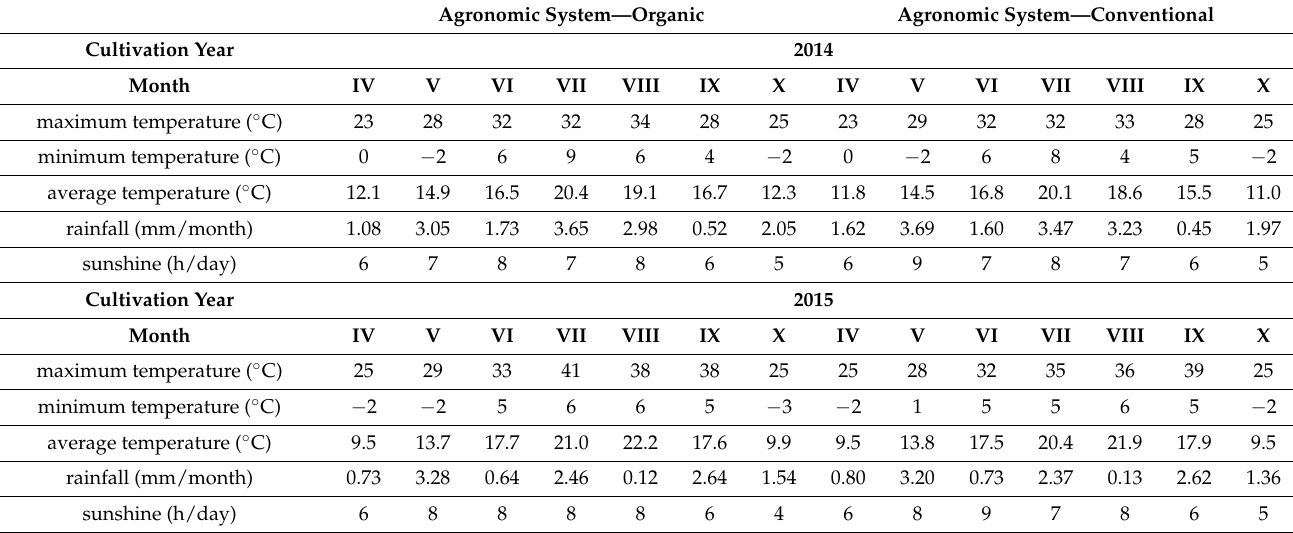
Table 1. Weather conditions in experimental farms (organic and conventional) 2014–2015 in time of blackcurrant fruits de- velopment. Agronomic